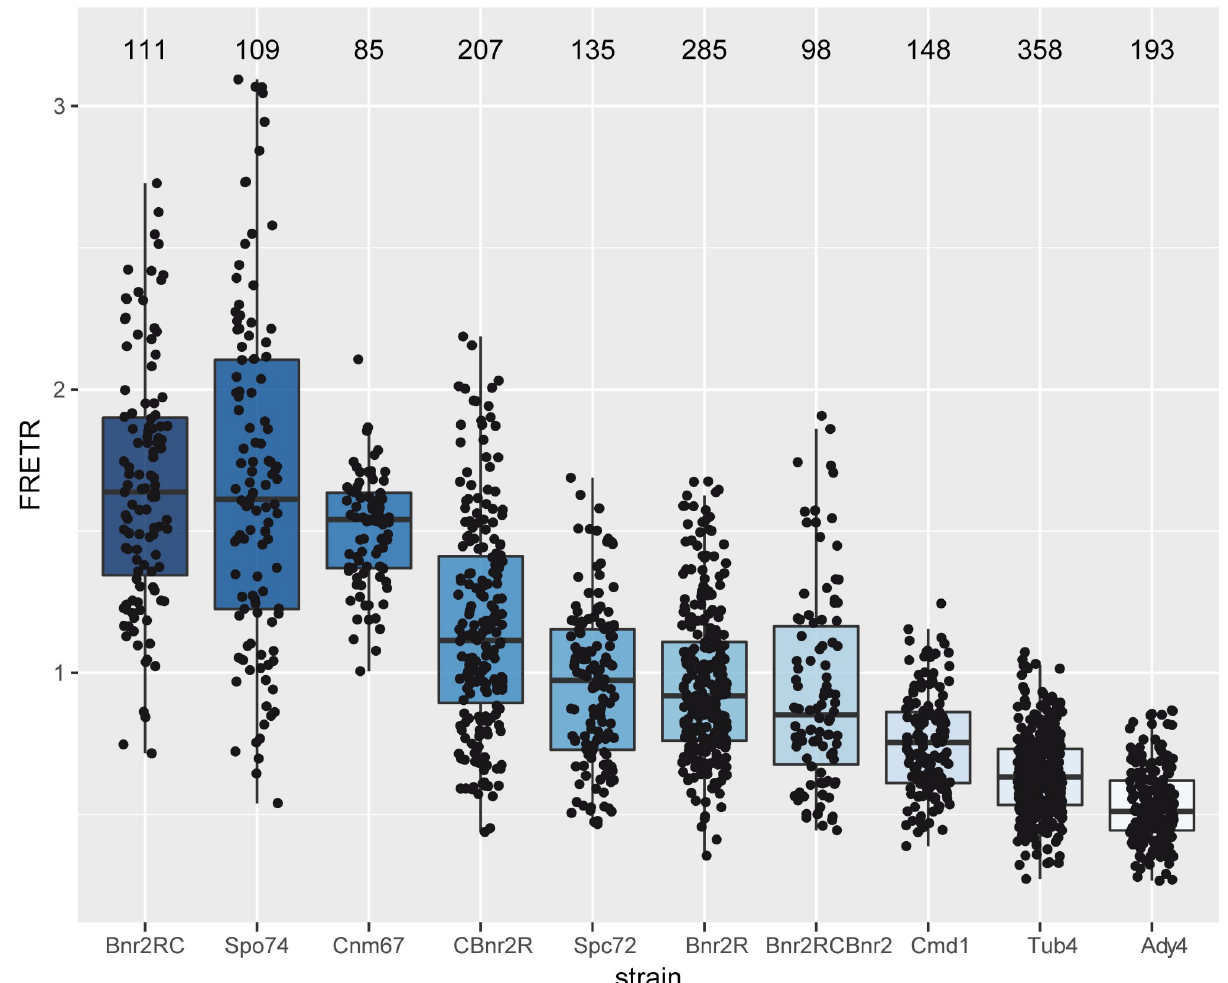
Fig 2. Boxplot of FRETR-values measured for the indicated strain. The FRETR-values were calculated as described in Materials and Methods. The horizontal bar in the box represents the median. The hinges represent the 25th and 75th percentiles. The whiskers extend 1.5 times the inter-quartile range from each hinge. Individual data is plotted as an overlaid scatter plot. The number plotted above each bar represents the number of individual SPBs measured for each strain.